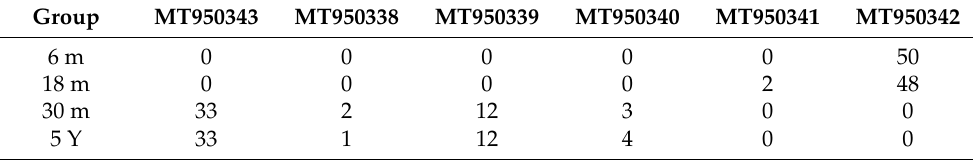
Table 4. The number of alternative spliceosomes at the different stages of the yak TSSK4 gene. Group MT950343 MT950338 MT950339 MT950340 MT950341